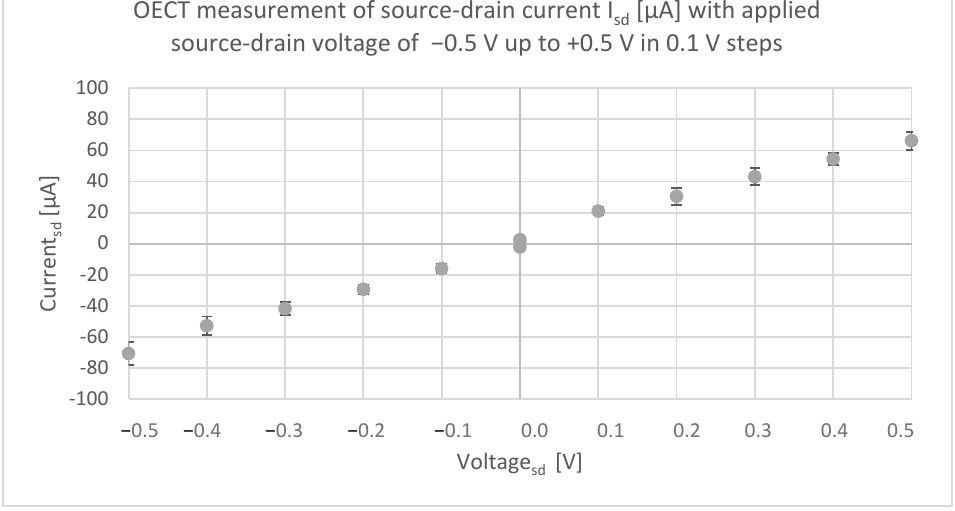
Figure 8. First OECT measurement of source/drain current I sd [ μ A] showing the characteristic curve of a transistor when the V sd is increased from − 0.5 to +0.5 V.